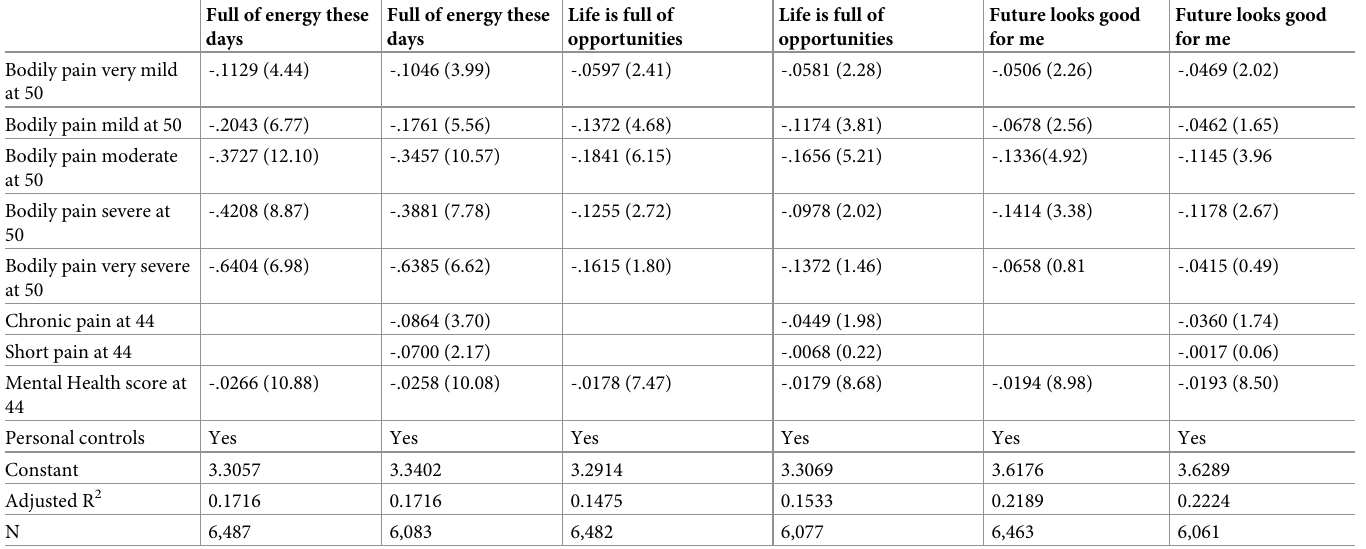
Table 14. Attitudes in NCDS9 at age 55.